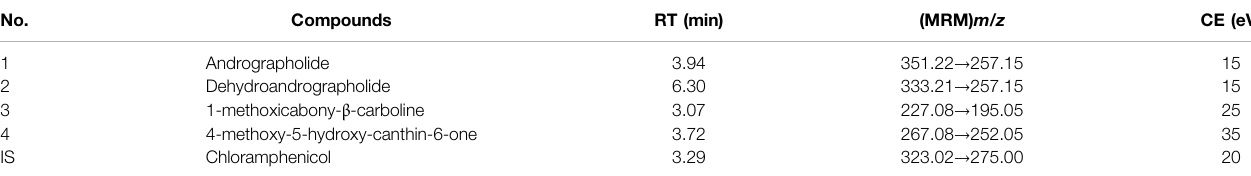
TABLE 1 | The mass spectrometry parameters of tested